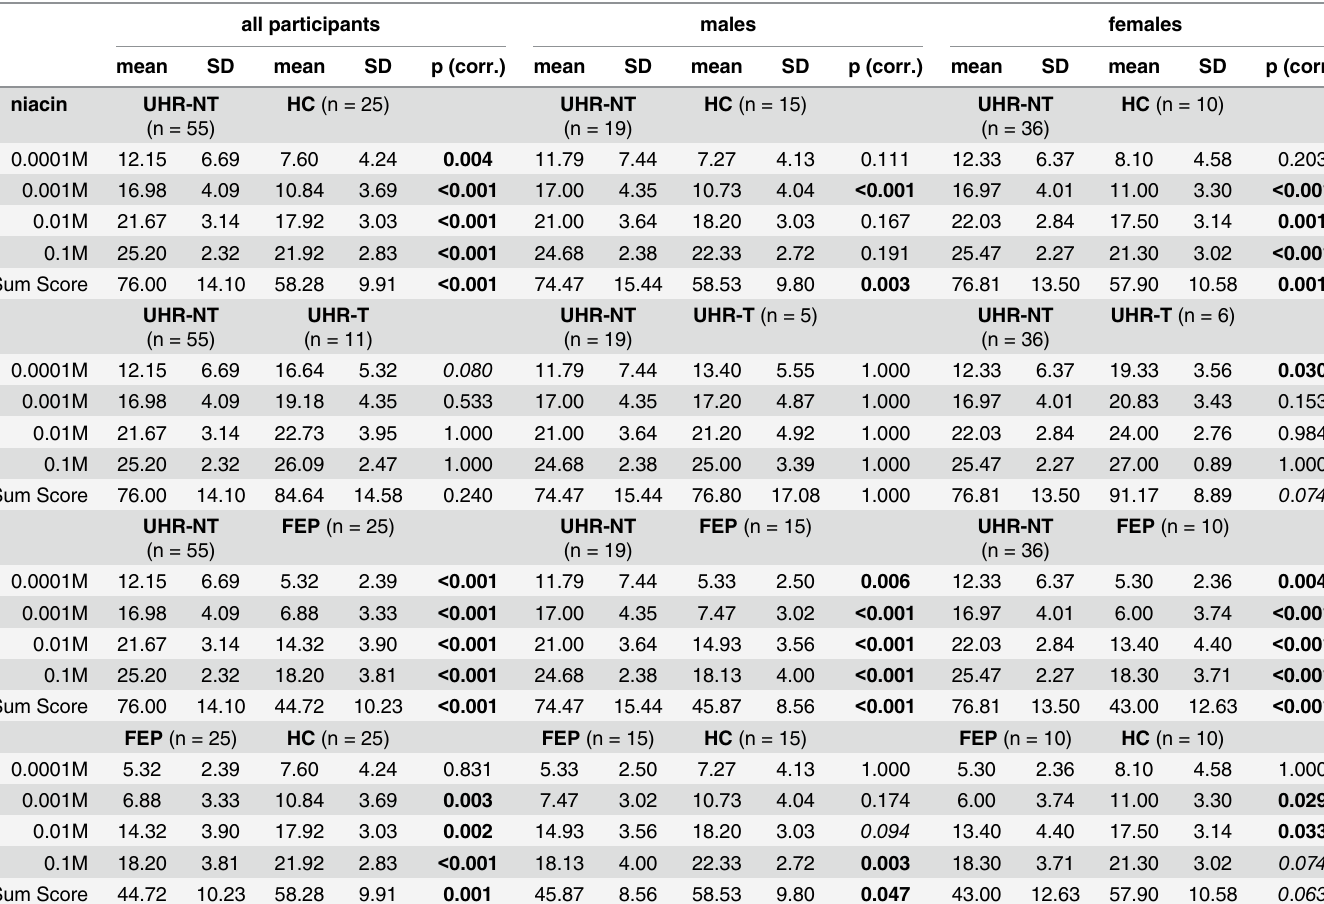
Table 3. Bonferroni corrected results of post-hoc comparison of single groups as revealed by